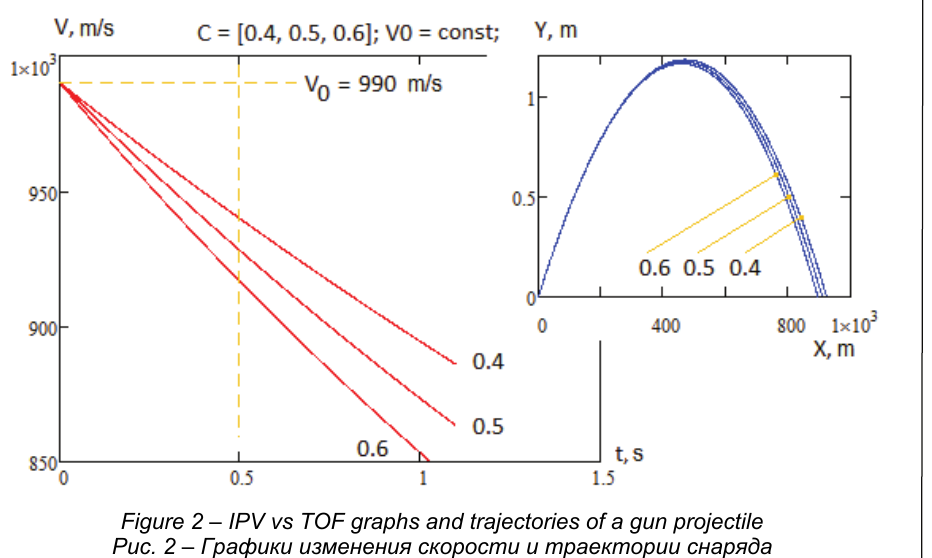
Figure 2 – IPV vs TOF graphs and trajectories of a gun projectile Рис . 2 – Графики изменения скорости и траектории снаряда Слика 2 – Графици тренутне брзине пројектила ( ТБП ) и времена лета и путање артиљеријског пројектила The angle of departure is assumed equal to 19 angular min.